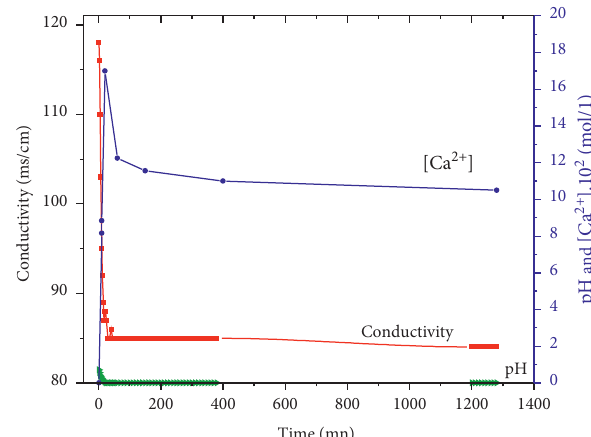
Figure 10: Variation of the conductivity, pH, and Ca 2+ concen- tration of mixture M 5 as a function of time.